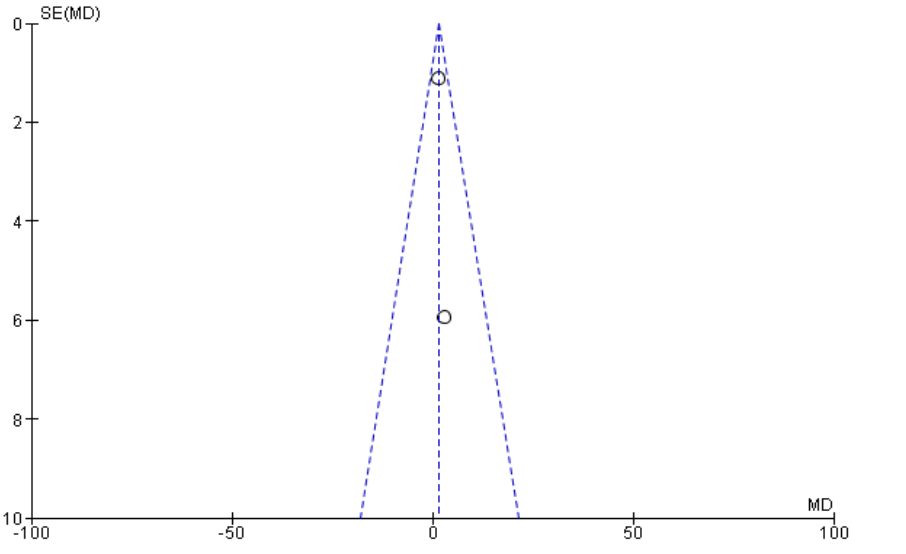
Figure 5. Funnel plot for clear aligner between before and after treatment.